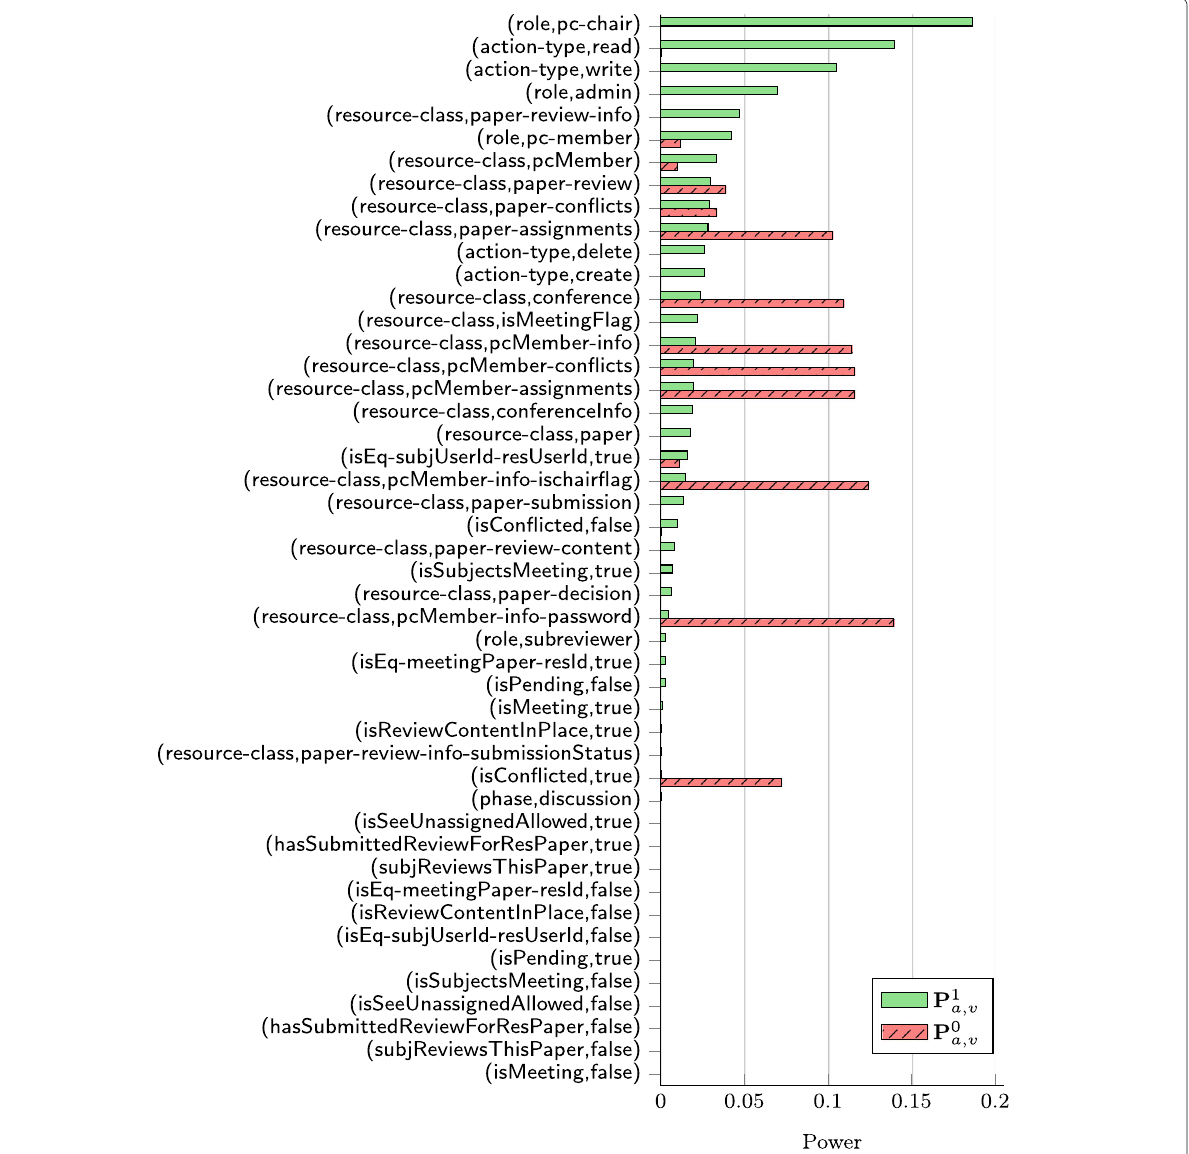
Fig. 4 Power distribution for the C ONTINUE policy: the plain green bar indicate the power for the decision 1 for each attribute value, while the patterned red bars indicate the power for the decision 0